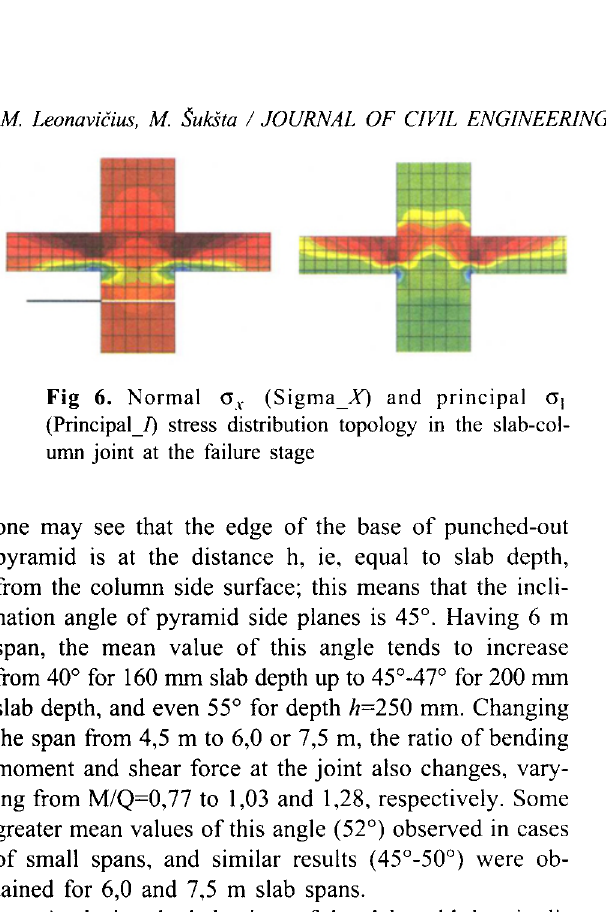
Table I. Punching force Fsh values at the slab-column joint for the cases of non-reinforced and longitudinally reinforced slabs F,,IU"' *h (MN/m'), when reinforcement ratio Fig 8. Normal ~.Y (Sigma_X) and principal <J1 0